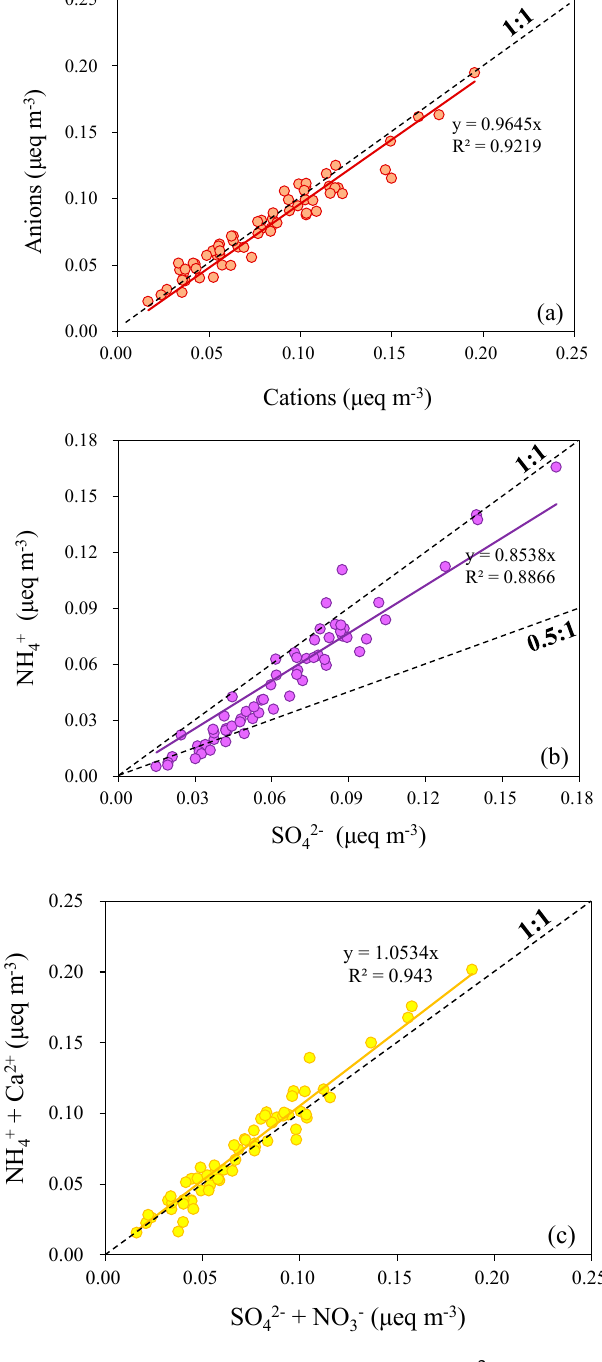
Figure 1. Correlation of ( a ) anions and cations, ( b ) NH 4 + and SO 4 2 − , ( c ) NH 4 + + Ca 2 + and SO 4 2 − + NO 3 − equivalent concentration in PM 2.5 .